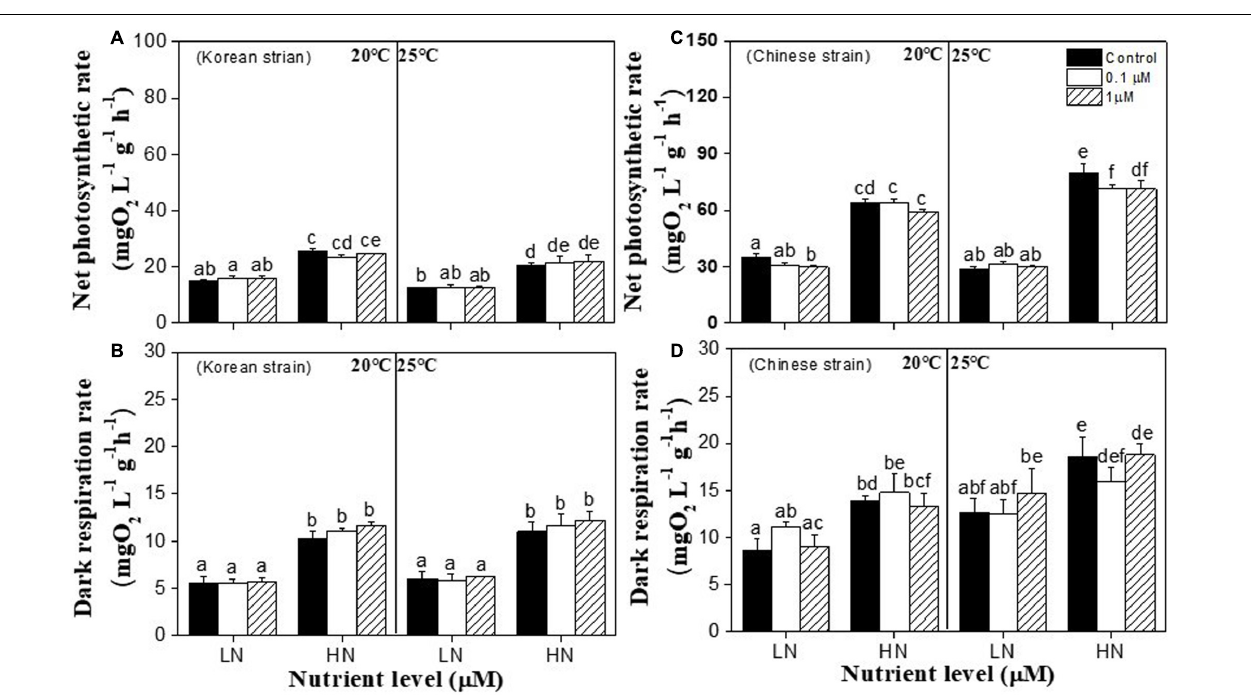
FIGURE 2 | Net photosynthetic rate (NPR) in a Korea strain (A) and Chinese strain (C) , and dark respiration rate (R d ) in a Korea strain (B) and Chinese strain (D) of Ulva prolifera cultivated under various experimental conditions. The error bars represent the standard deviation ( n = 3). Low nutrient = 50 µ M nitrate and 5 µ M phosphate (LN); high nutrient = 250 µ M nitrate and 25 µ M phosphate (HN). Different letters above the error bars represent statistical significance ( P < 0.05) among different